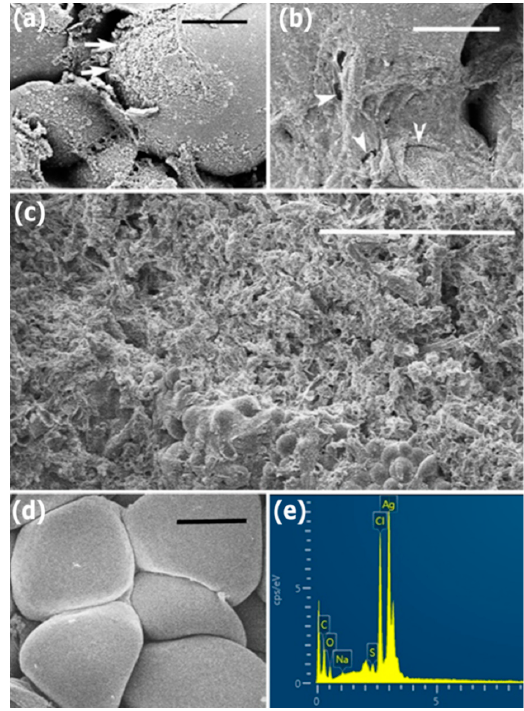
Figure 7. The micrographs of scanning electron microscopy and energy dispersive spectroscopy, after sclerotia were treated by 200 μ g/mL AgNPs: ( a , b ) Five days; ( a ) Lamellar fragments (arrows) on the surfaces of hyphae cells. Scale bar = 4 μ m; ( b ) Micropores or fissures (arrowheads) on the surfaces of hyphae cells. Scale bar = 4 μ m; ( c ) Seven days. Mycelia die on the surfaces of a sclerotium. Scale bar = 100 μ m; ( d ) Control. Hyphae cells indicate regular shapes on the surfaces of a sclerotium. Scale bar = 5 μ m. ( e ) Energy dispersive spectroscopy.